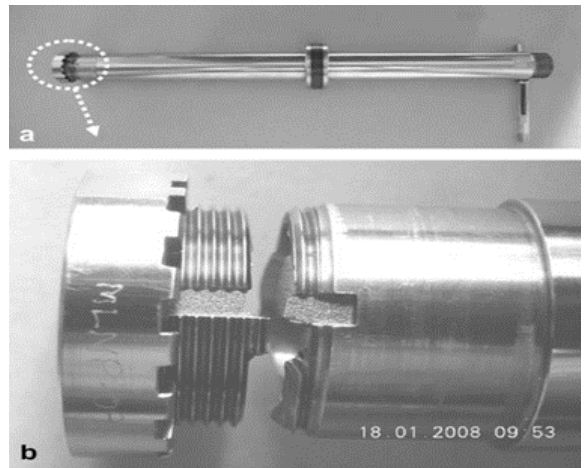
Figure 26. Photographs showing ( a ) the failed piston and ( b ) the location of failure [195].